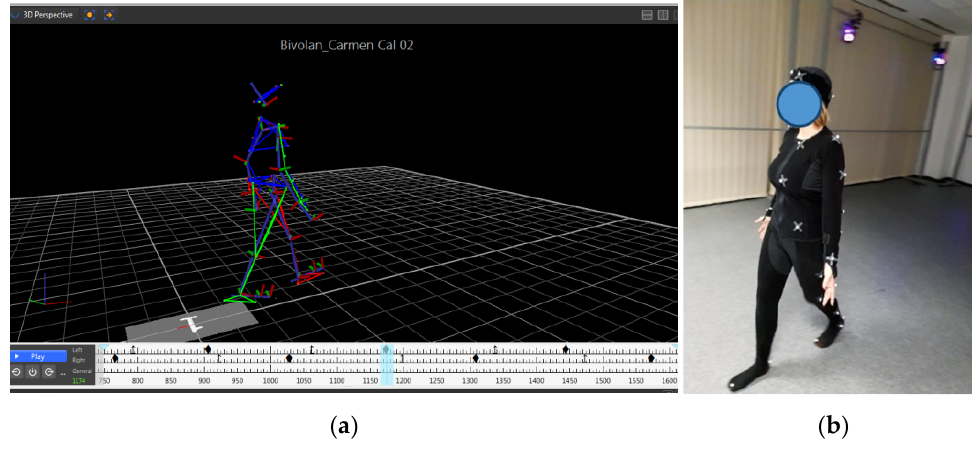
Figure 2. Video capture during an experimental test: ( a ) print screen during video motion analysis; ( b ) snapshot during experimental analysis.